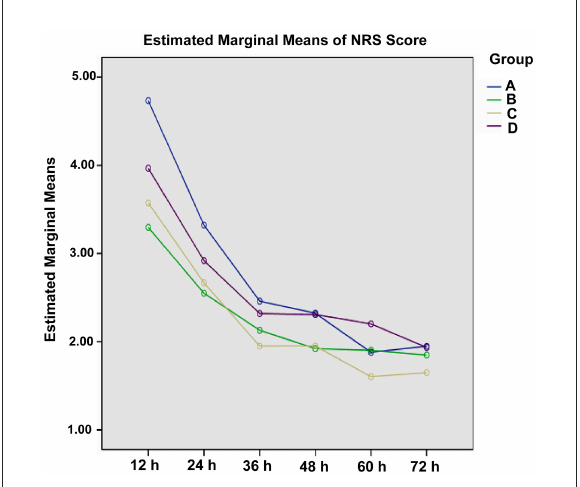
FIGURE1 Estimated marginal means for the NRS score of four titration strategies at each data collection